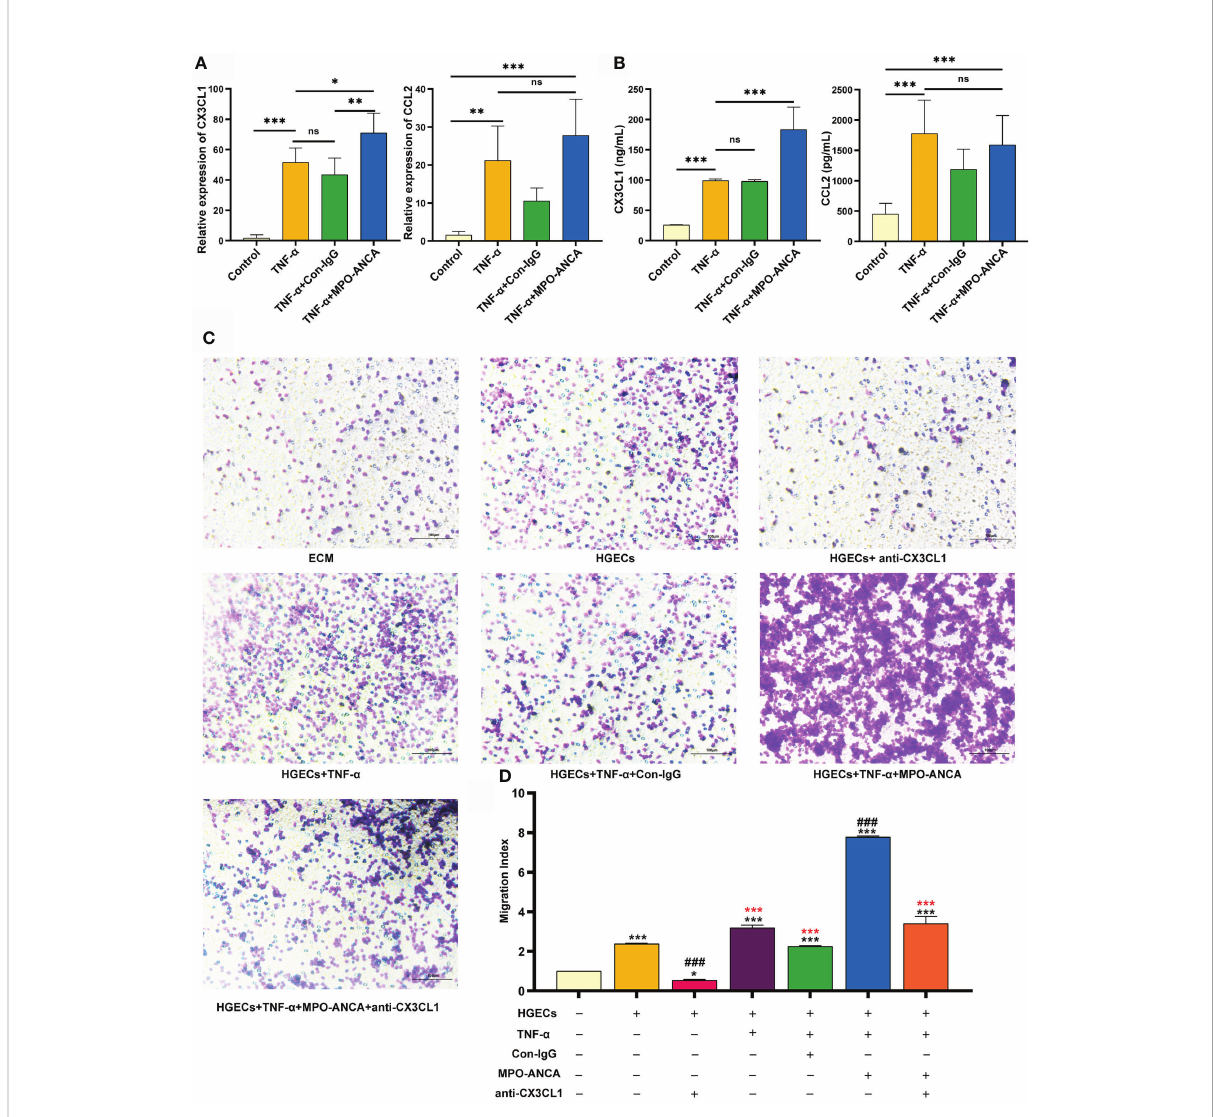
FIGURE 3 MPO-ANCA enhanced the recruitment of CD16 + monocytes by the CX3CL1-CX3CR1 axis in glomerular endothelial cells. (A) The production of CX3CL1 and CCL2 by HGECs stimulated with TNF- a , MPO-ANCA, or Con-IgG was measured by RT-qPCR and (B) ELISA. ns, not signi fi cant. * p <0.05; ** p <0.01; *** p <0.001. (C) In vitro migration assay of CD16 + monocytes with the culture supernatants of HGECs, migrated CD16 + monocytes were stained by Wright staining. (D) ECM wells were used as an indicator of conversion ef fi ciency to obtain migration index; *vs. ECM group, * p <0.05, *** p <0.001; # vs. HGECs group, ### p <0.001; *(red) vs. TNF- a +MPO-ANCA cultured HGECs group, ***(red) p <0.001. ECM, endothelial cell medium; HGECs, Human glomerular endothelial